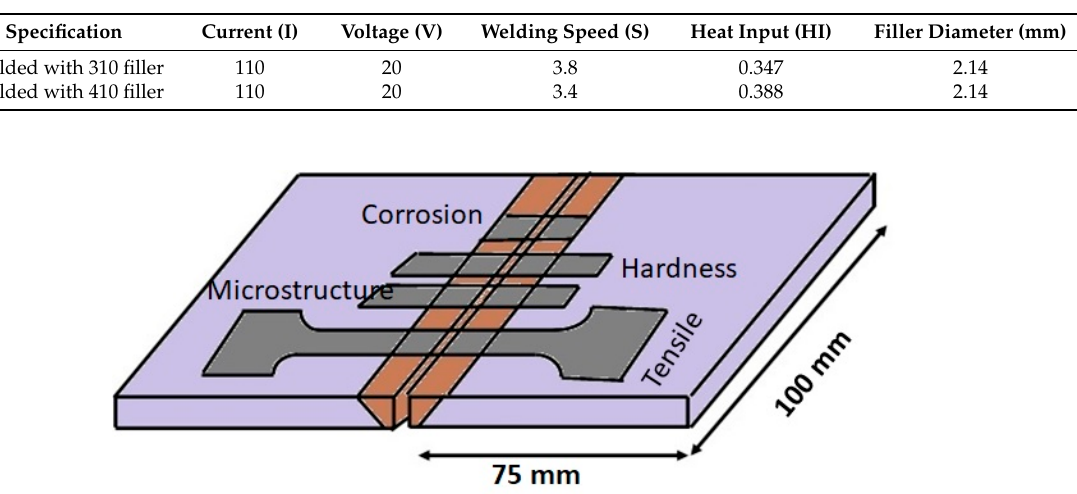
Table 2. Welding process parameters for both the